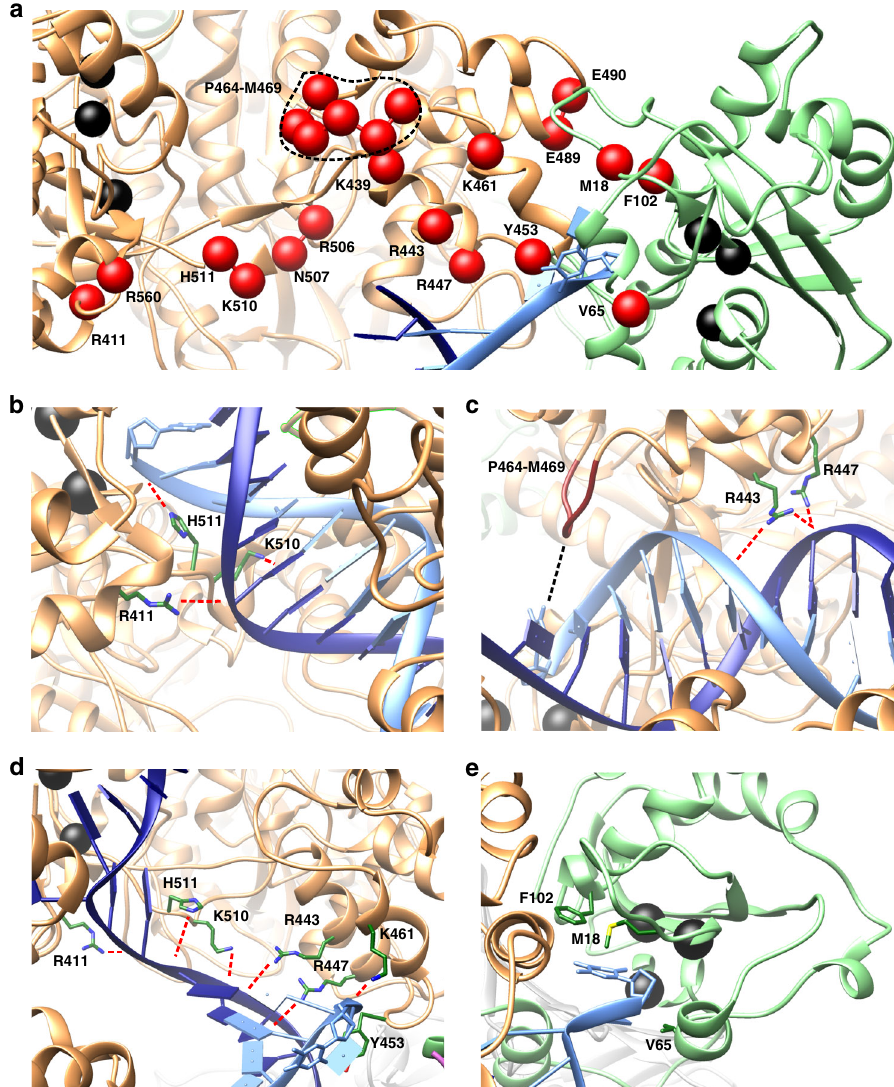
Fig. 5 Speci fi c interactions along the optimal path accommodate the transitioning primer end to ensure facile pol-to-exo switching. a Key residues (critical nodes) for pol-to-exo mode switching determined from dynamic network, conservation, and persistent contacts analyses and mapped onto the Pol III structure. Critical nodes are shown as spheres, labeled and colored in red. Polymerase and exonuclease active site residues are shown as spheres and colored in black. b – d Palm and thumb domain residues of the α subunit forming contacts important for polymerization ( b , c ) and for transitioning the primer end ( d ). Residue sidechains are shown in stick representation and labeled and colored by atom type (C is green, N is blue, and S is yellow). Salt- bridge and polar interactions to the DNA are shown as dashed red lines. Hydrophobic interactions are shown as a dashed black line. e Stabilization of the incoming mismatched nucleotide by the hydrophobic cluster of the ε subunit. Residues from the ε subunit hydrophobic patch are shown as sticks, labeled and colored in